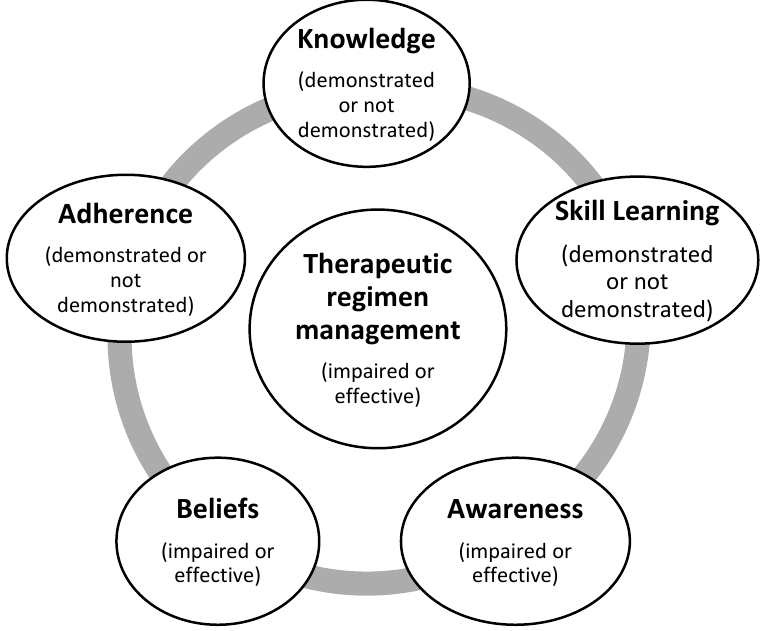
Figure 2. Nursing Diagnostic criteria for therapeutic management in chronic disease patients [7,12].